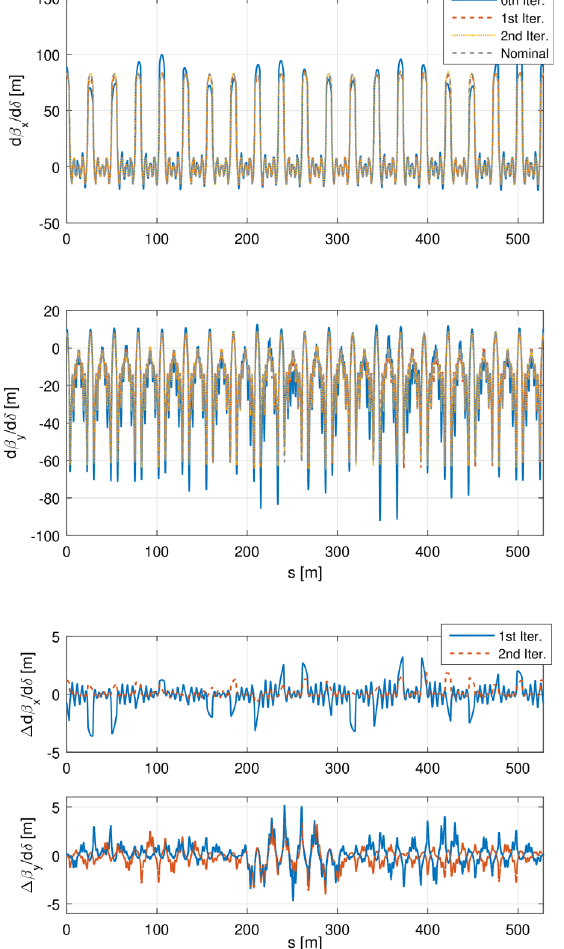
FIG. 13. Chromatic functions of the ring with each iteration of corrections. The chromatic functions were extracted from the fitted